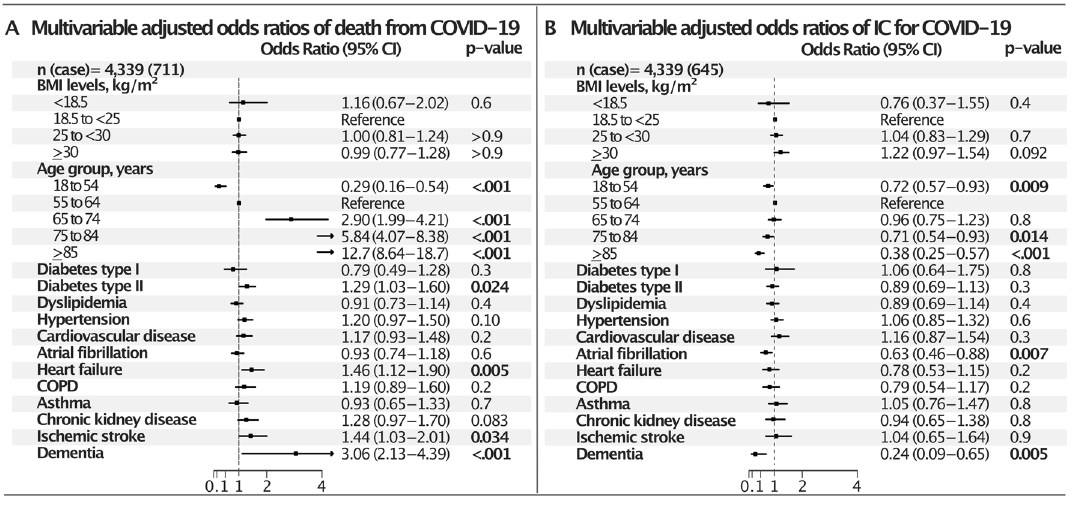
Figure 4. Multivariable adjusted odds ratios of IC and death from COVID-19, in men. COPD chronic obstructive pulmonary disease, IC intensive care. (A) Multivariable adjusted odds ratios of death, (B) multivariable adjusted odds ratios of